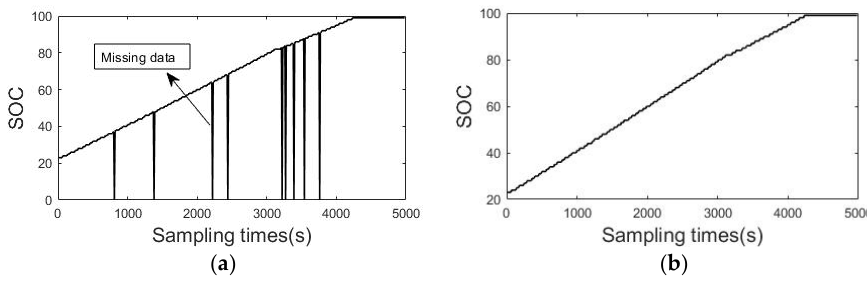
Figure 1. The SOC data acquired form NEVs, ( a ) before interpolation, ( b ) after interpolation. In the electric vehicle data, the charging and discharging segments should be sepa- rate from the data sequence for SOH prediction method design. The difference in SOC and current values during the charging and discharging processes can be used to divide the charging and discharging segments. After the treatments, hundreds of charging/dis- charging segments can be obtained.